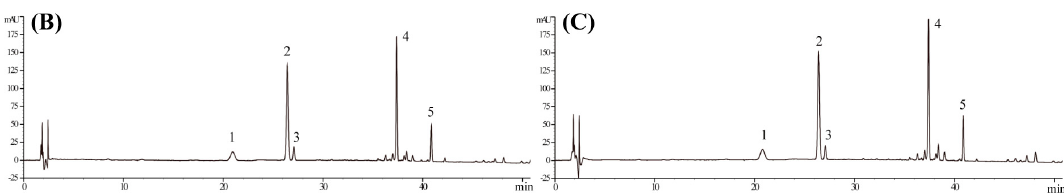
Figure 7. ( A ) Chemical structures of the main compounds in Panax notoginseng saponins. ( B ) Chromatogram profiles of PNS reference. ( C ) Chromatogram profiles of PNS extract. The main components of PNS in the chromatograms are as following: 1. Notoginsenoside R 1 ; 2. Ginsenoside Rg 1 ; 3. Ginsenoside Re; 4. Ginsenoside Rb 1 ; 5. Ginsenoside Rd. UV absorbance of the HPLC samples was monitored at 203